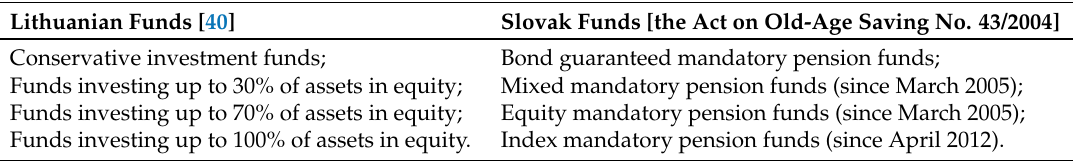
Table 2. Funds arranged into four groups based on the investment